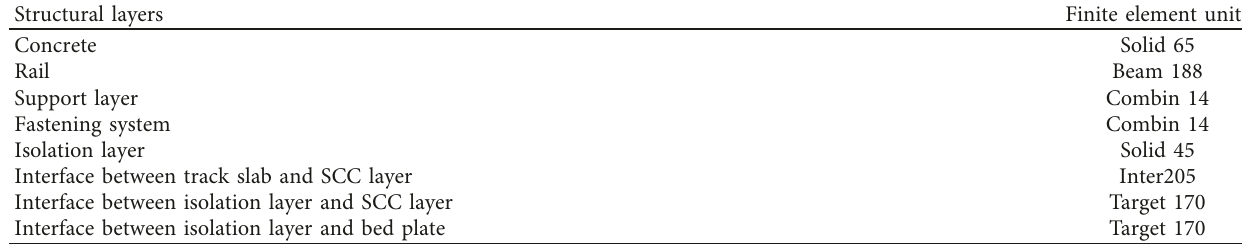
Figure 11: The finite element model of the CRTS III slab ballastless track system. Table 6: The finite element units of main structural layers.